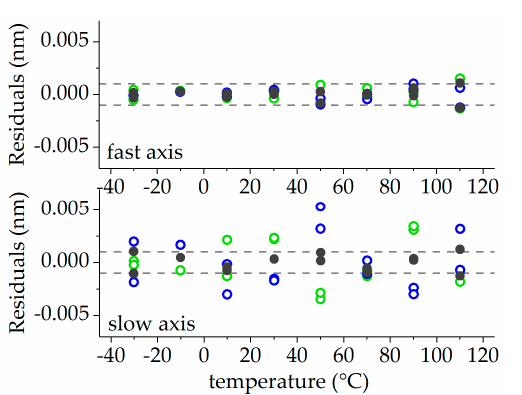
Figure 8. Temperature calibration of the surface-attached PM tandem: FBG in the 0°-orientation in green, FBG in the 90°-orientation in blue, and mean values in grey.